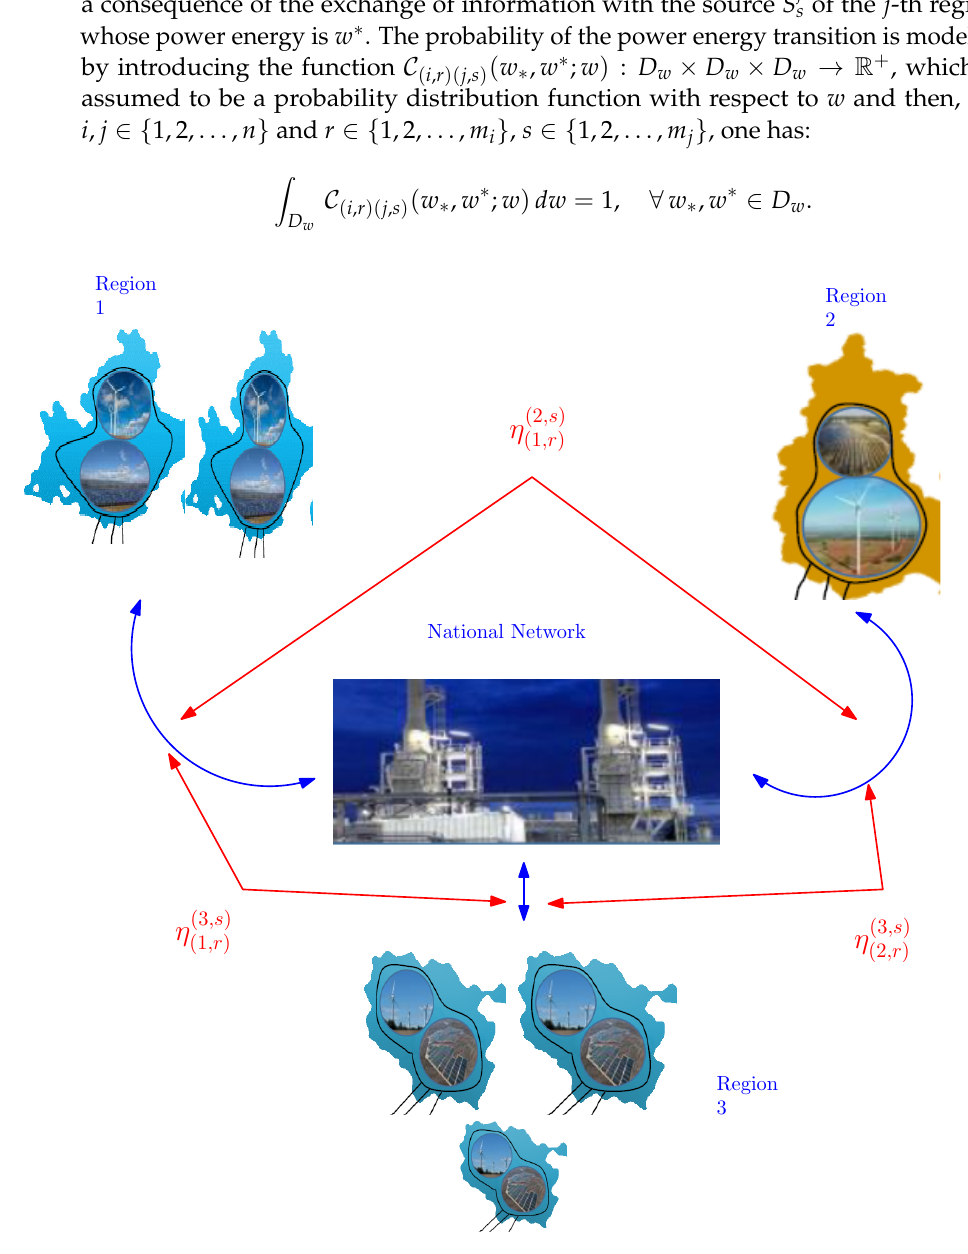
Figure 1. A network composed of different regions containing different energy sources ( n = 3, m 1 = 4, m 2 = 2 and m 3 =